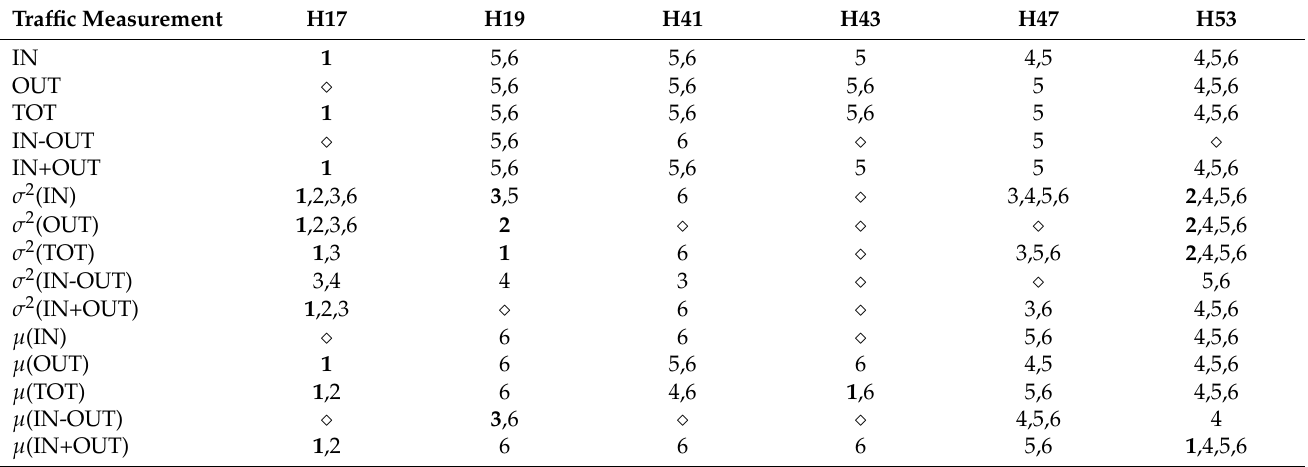
Table 6 gives the traffic types and lags for which H was rejected at p ≤ 0.05, which χ 2 ,0 occurred in 142 out of 540 tested cases. Table 6. Lags for which H χ 2 ,0 was rejected for monitored hives; IN—incoming traffic; OUT—outgoing traffic; TOT—total traffic; σ 2 (X)—variance of X; µ (X)—mean of X; (cid:5) means that H χ 2 ,0 was not rejected for any lag; bolded lags are the lags for which both recommendations at the end of Section 2.6 are